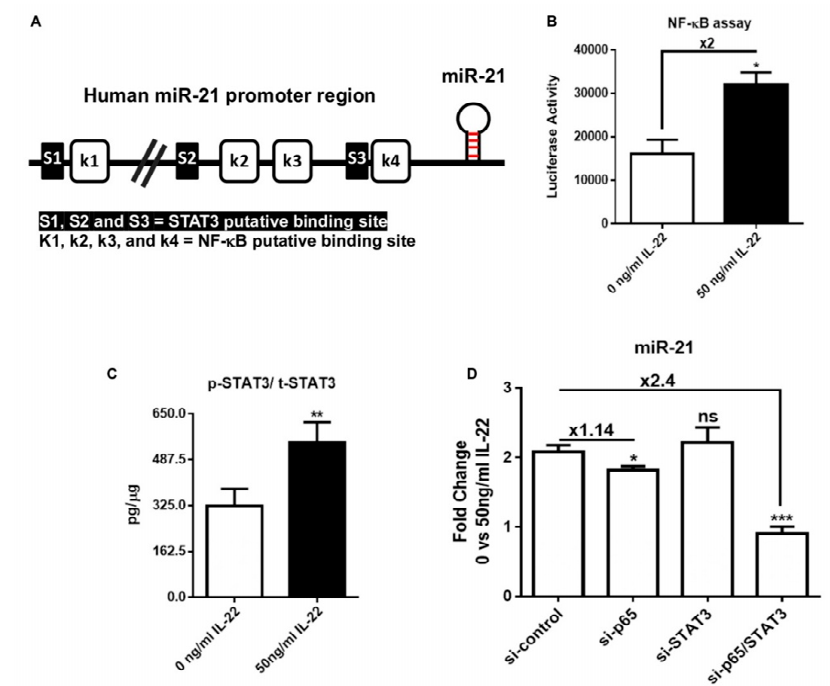
Figure 4. Requirements of STAT3 and NF ‐κ B signaling for the induction of miR ‐ 21 ‐ 3p in IL ‐ 22 ‐ stimulated keratinocytes. ( A ) Schematic representation of the miR ‐ 21 promoter gene with the putative binding sites for STAT3 (S1, S2, and S3) and NF ‐κ B (k1, k2, k3, and k4) transcription factors. ( B ) The luciferase activity of NF ‐κ B in HaCaT cells transfected with NF ‐κ B luciferase reporter construct was measured after 24 h of 50 ng/mL IL ‐ 22 stimulation. ( C ) IL ‐ 22 induction of the STAT3 pathway in HaCaT cells was evaluated using a cell ‐ based ELISA kit. ( D ) Representation of the fold change in miR ‐ 21 (5p and 3p) relative expression, assessed via RT ‐ qPCR. The fold change corresponds to the ratio of 50 ng/mL IL ‐ 22 over 0 ng/mL IL ‐ 22 ‐ treated HaCaT cells and silenced with si ‐ Ctrl, si ‐ p65, si ‐ STAT3, or si ‐ p65/STAT3 for 24 h. Data information: results are presented as mean values ± SEM. Data for B and C are representative of two independent experiments and for D are representative of three independent experiments performed in triplicate. The statistical comparison between groups was performed using the two ‐ tailed Student’s t ‐ test: * p < 0.05, ** p < 0.01, *** p < 0.001.